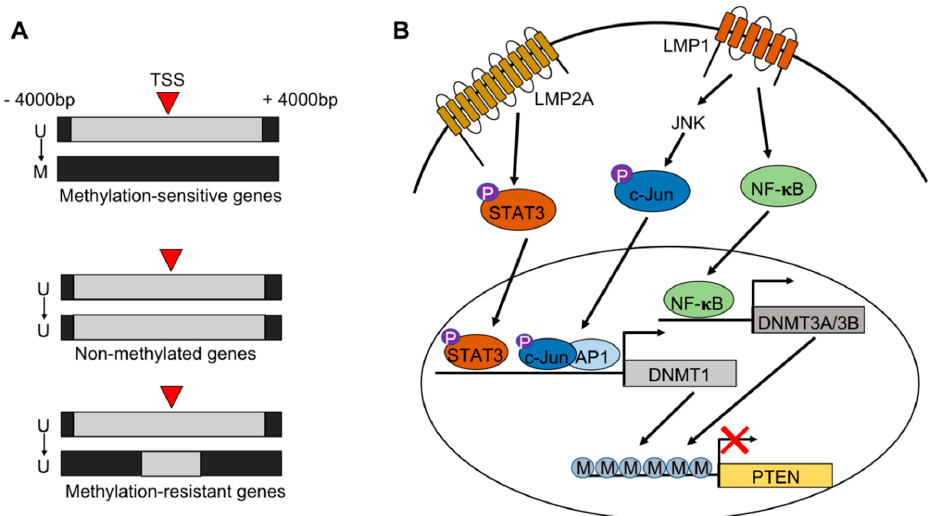
Figure 1. Methylation induction following Epstein-Barr virus (EBV) infection of epithelial cells. ( A ) Subtypes of genes that are unmethylated prior to EBV infection. Methylation occurs at and